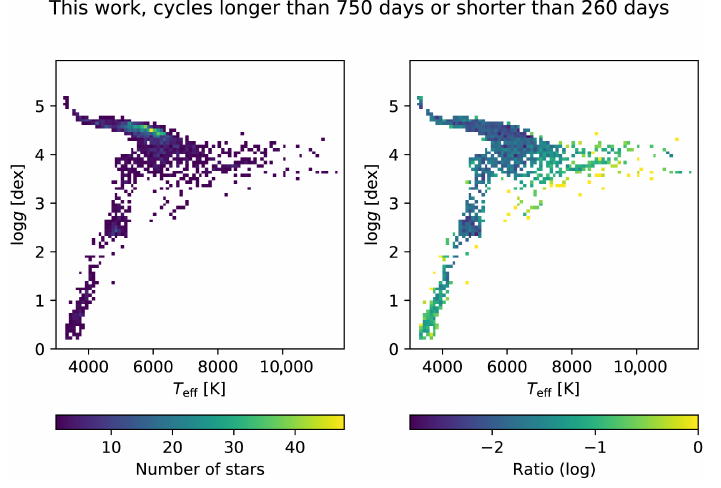
Figure 16. The left panel is the same as the middle panel of Figure 14, and the right panel is the same as the right panel of Figure 14, but remove the stars with cycle candidates between 260 days and 750 days, since these cycles are more likely to be false signals due to CCD effects (Section